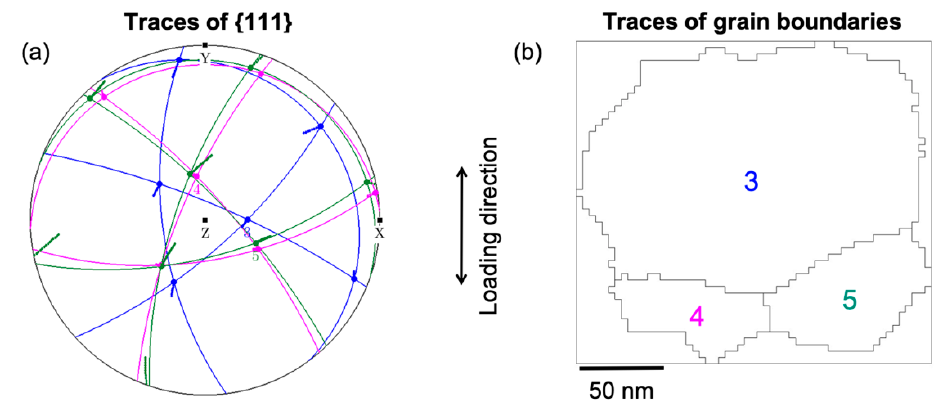
Figure 11. ( a ) Traces of {111} planes of grains 3, 4, and 5. Other marking conventions are the same as shown in Figure 8. ( b ) Grains 3, 4, and 5 with traces of their grain boundaries and the rotation axes and their sense of rotation.